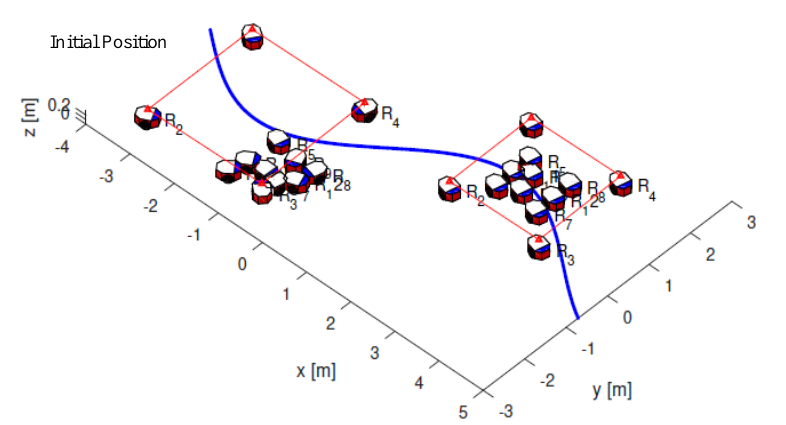
Figure 14. The trajectory of the leader robots and following robots